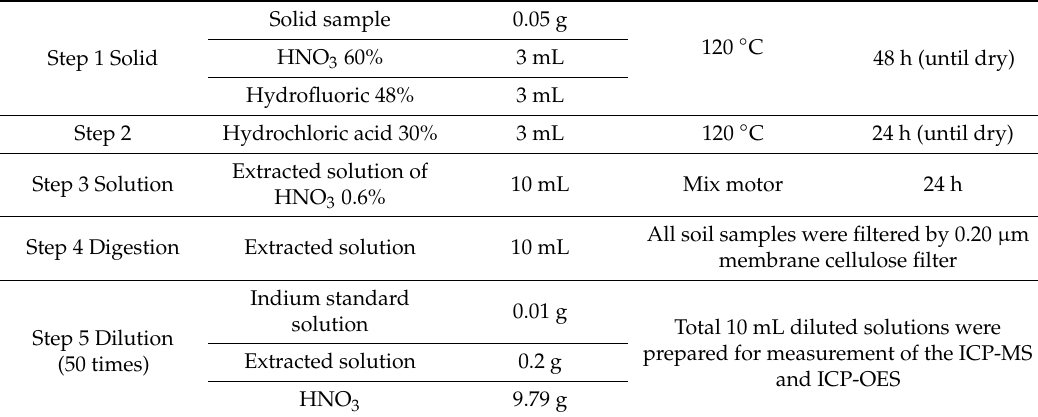
Table 1. Procedures of the